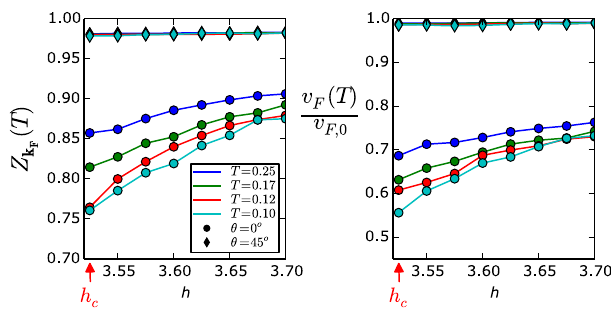
FIG. 19. (a) Z k as a function of h for different temperatures. F Circles (diamonds) correspond to θ ¼ 45 ° ( θ ¼ 0 °) (where θ is defined in the inset of Fig. 18). (b) The Fermi velocity =v renormalization v [where v is defined in Eq. (14) and F F; 0 F v is the noninteracting Fermi velocity] as a function of h for F; 0 θ ¼ 0 °,